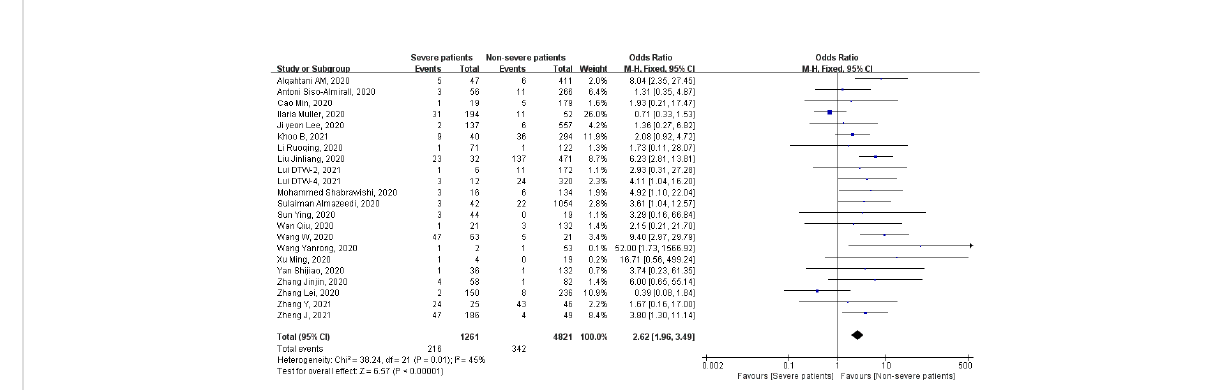
FIGURE 2 Forest plot of the association of the severity of coronavirus disease 2019 (COVID-19) infection with thyroid